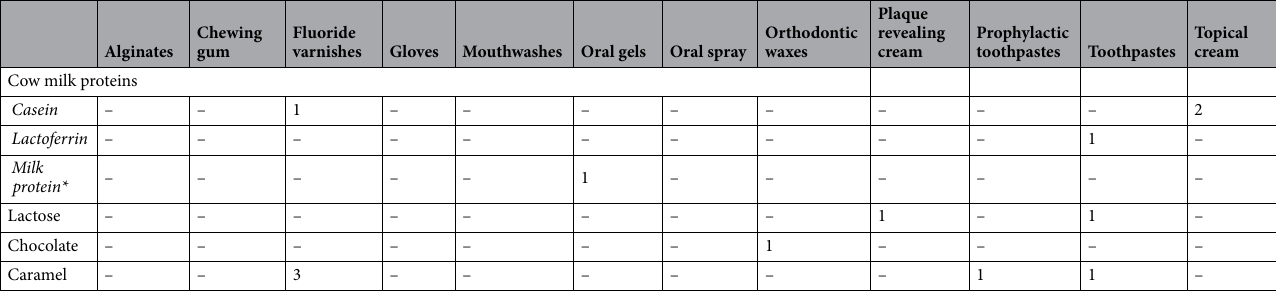
Table 3. Dairy allergens in the studied OCP labeling. *No specification on the label of which milk protein was